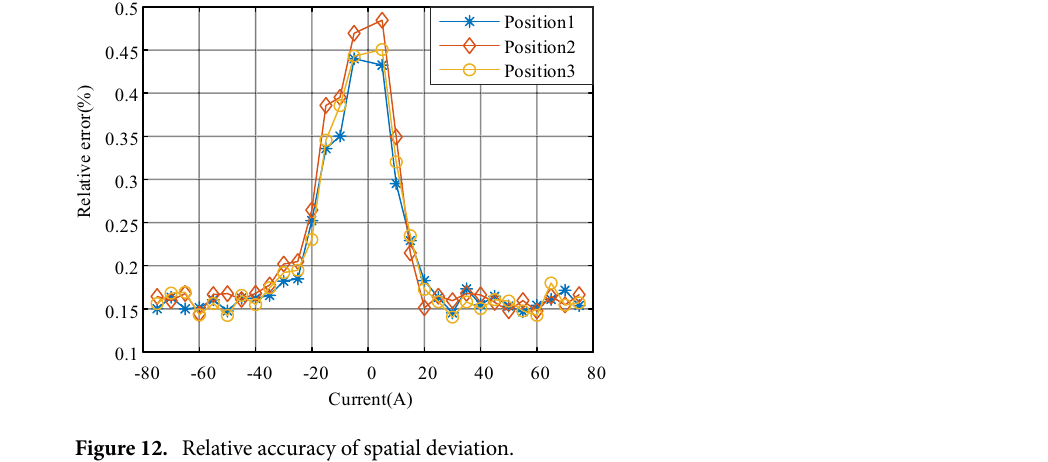
Figure 12. Relative accuracy of spatial